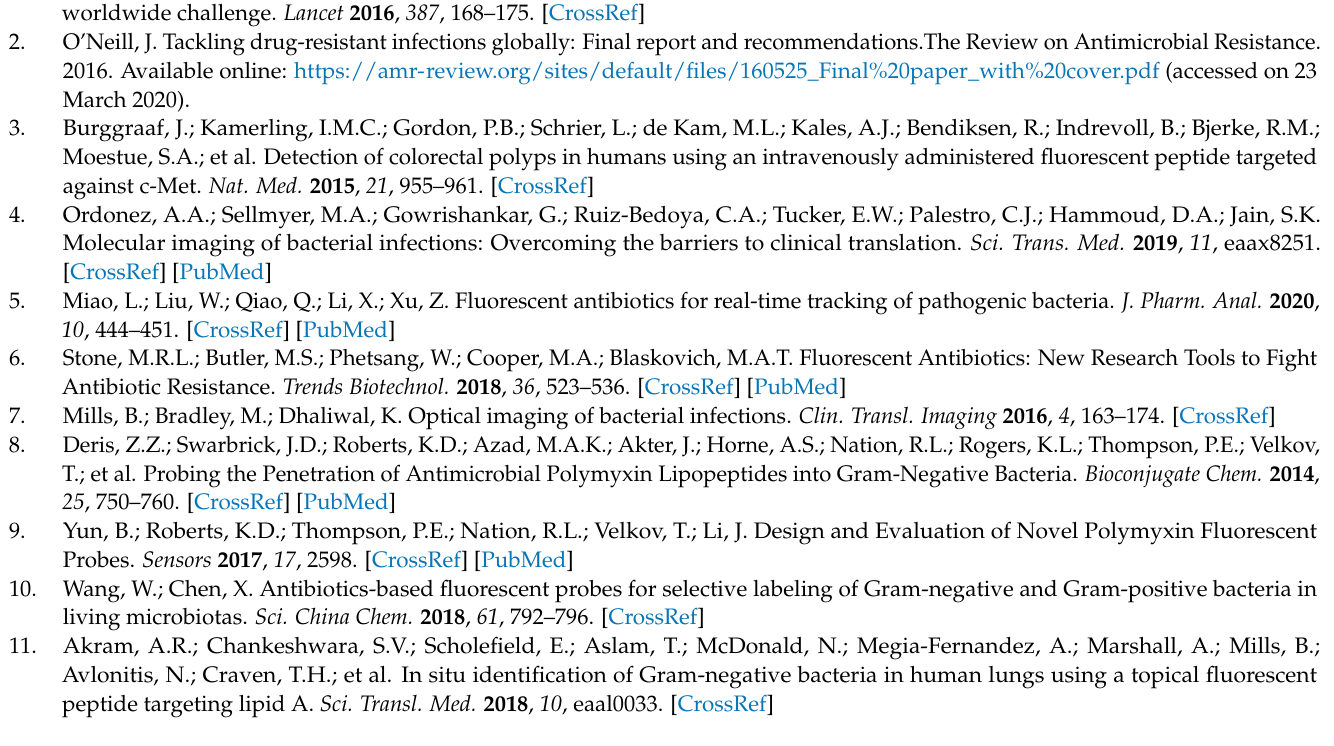
solvents. Figure S5. Time-resolved fluorescence spectra of compound 1 in different solvents. Figure S6. Time-resolved fluorescence spectra of compound 2 in different solvents. Figure S7 . Time-resolved fluorescence decay curves for compounds (a) 1 and (b) 2 in all solvents. The logarithm of normalized counts vs time over a nine nanosecond time range with 800 ps time resolution. Fluorescence counts were summed and normalised over a 586–603 nm wavelength